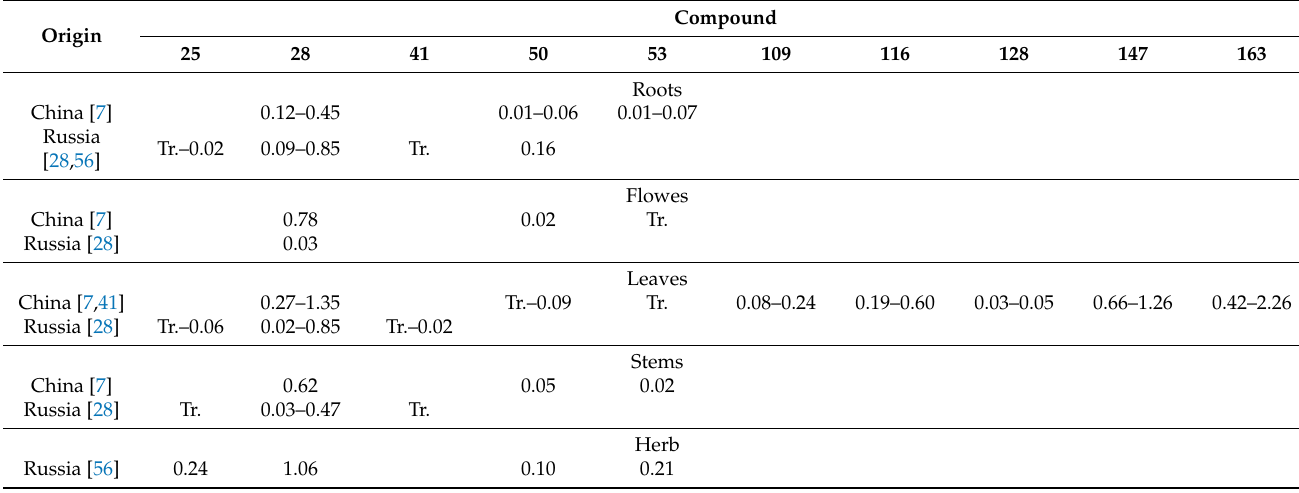
Table 4. Content of selected metabolites in R. uniflorum organs, % of dry plant